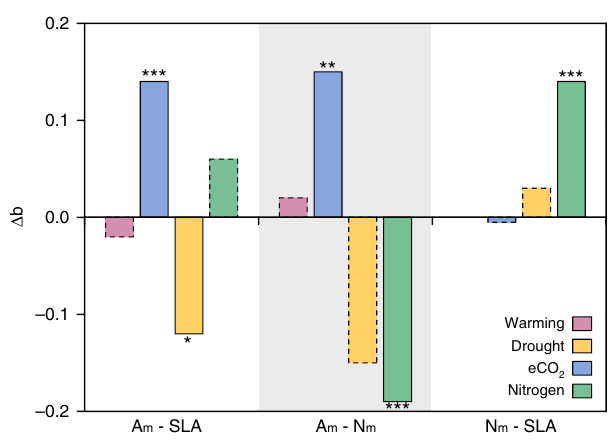
Fig. 5 Changes of elevations ( b ) for trait relationships under global environmental changes. The differences in SMA elevation via the SMA analog of standard ANCOVA. Signi fi cance: dashed borders: P > 0.05; * P < 0.05; ** P < 0.01; *** P (Fig. 4h) could be attributed to the increased Rubisco-use ef fi - ciency. The reduced photosynthetic N-use ef fi ciency under